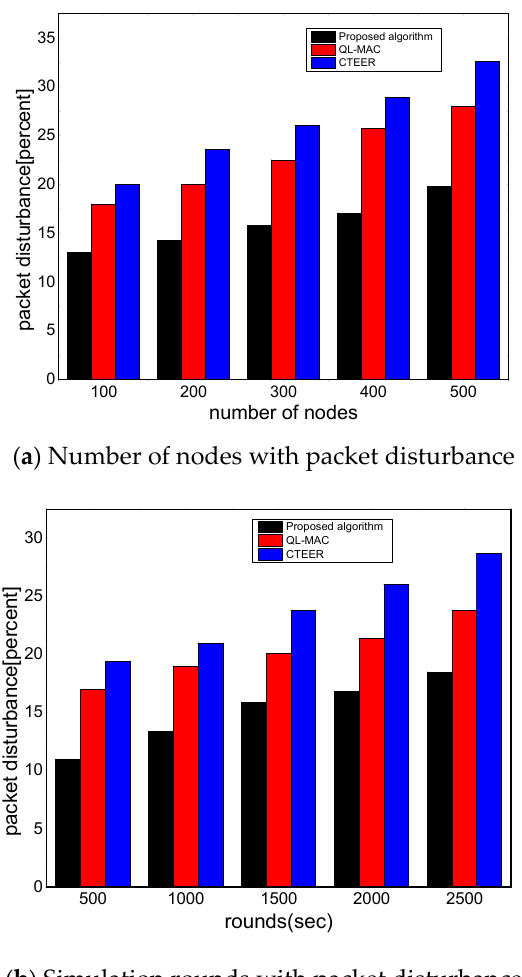
Figure 7. The performance evaluation of the proposed algorithm compared to QL-MAC and CTEER for packet disturbance.